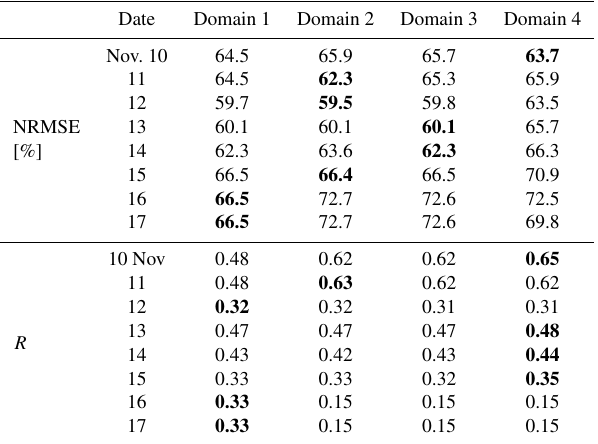
Table 4. Sensitivity tests for spatial coverage. Use of observational data in terms of spatial availability is tested. Domains 1–4 are shown in Fig. 3. The best performance is marked in